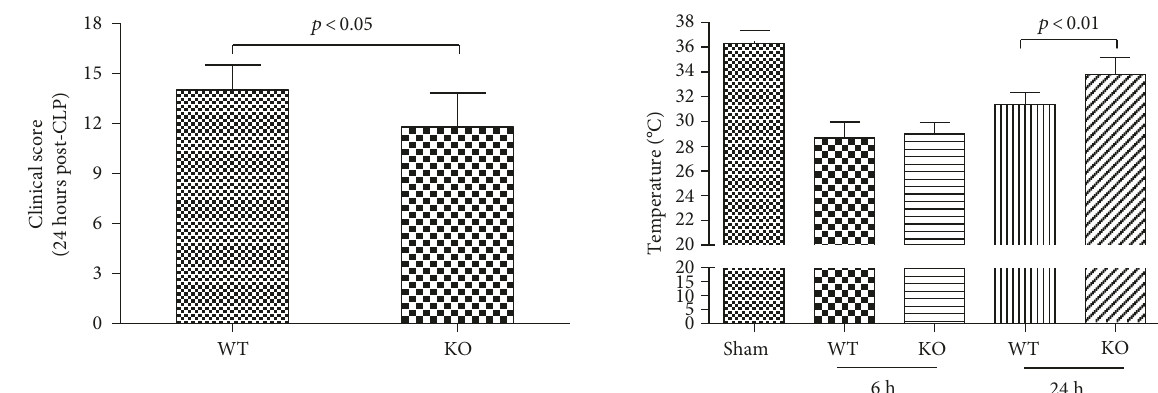
Figure 2: Lack of 5-HT reduces the clinical score and retains low body temperature in CLP-induced sepsis in mice. The clinical score was assessed at 24h, and the temperatures of the mice were measured at 6h and 24 h after CLP-induced sepsis ( n = 15 , mean ± SD, clinical score, p < 0 05 versus the WT-CLP group; temperature, p < 0 01 versus the WT-CLP group 24h after CLP-induced sepsis).